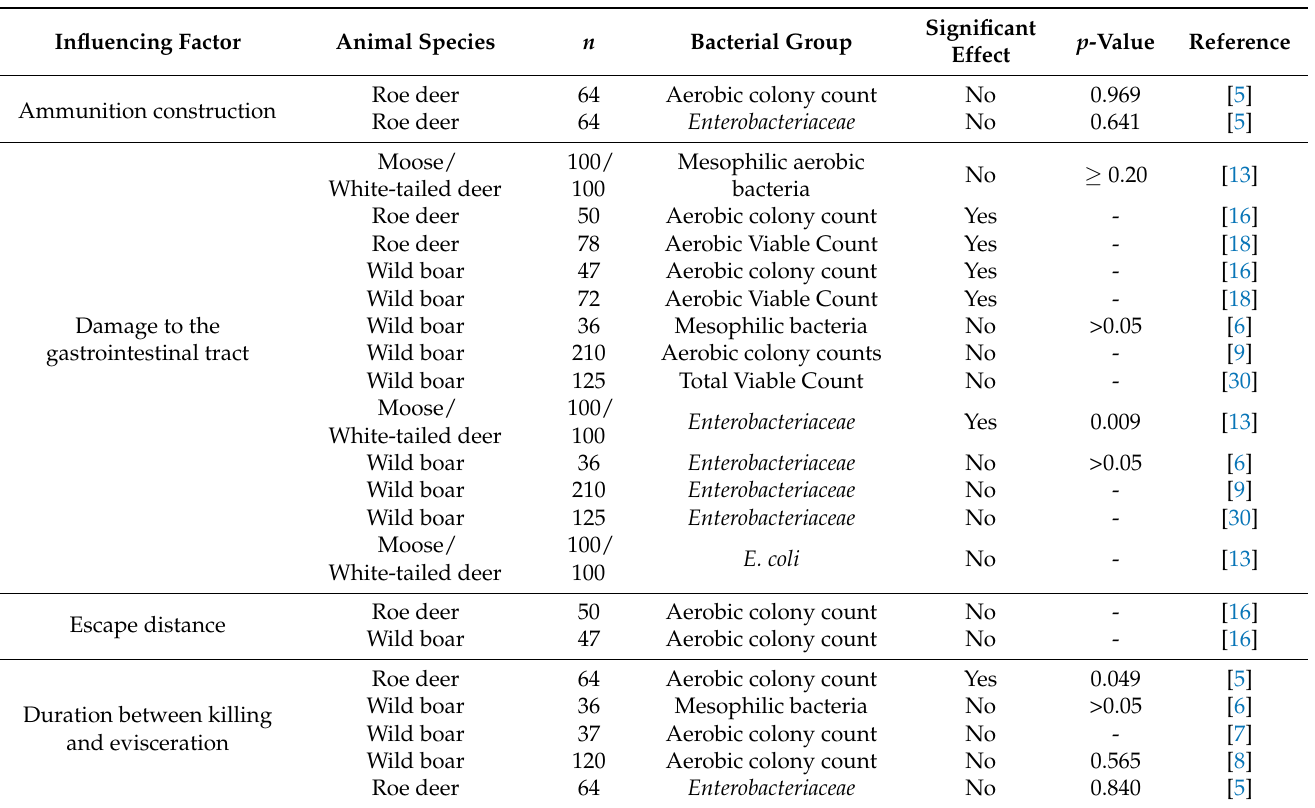
Table 5. Ammunition and shooting, hunting and handling factors that may influence the initial microbial load of game carcasses including animal species, sample size, p -value and bacterial group examined, reported in the original research